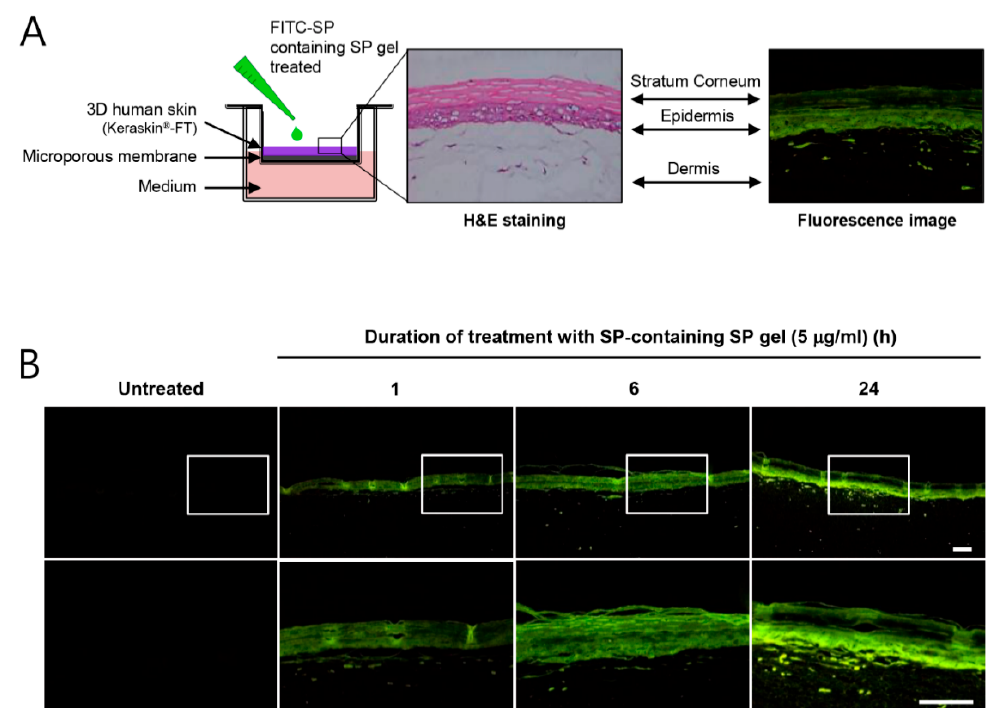
Figure 4. Skin absorption of SP gel into in-vitro reconstructed 3D human skin, keraskin ® -FT. ( A ) PBS or SP gel (containing FITC-labeled SP) was applied onto the stratum corneum of keraskin ® -FT. ( B ) Fluorescence images demonstrated the extent of absorption of SP gel. PBS (untreated) or SP gel (containing FITC-labeled SP) was topically applied for indicated duration. Frozen sections of skin tissues were observed under a fluorescence microscope. Scale bar = 1 mm. PBS, phosphate-buffered saline; FITC, fluorescein isothiocyanate; H&E, hematoxylin and eosin.